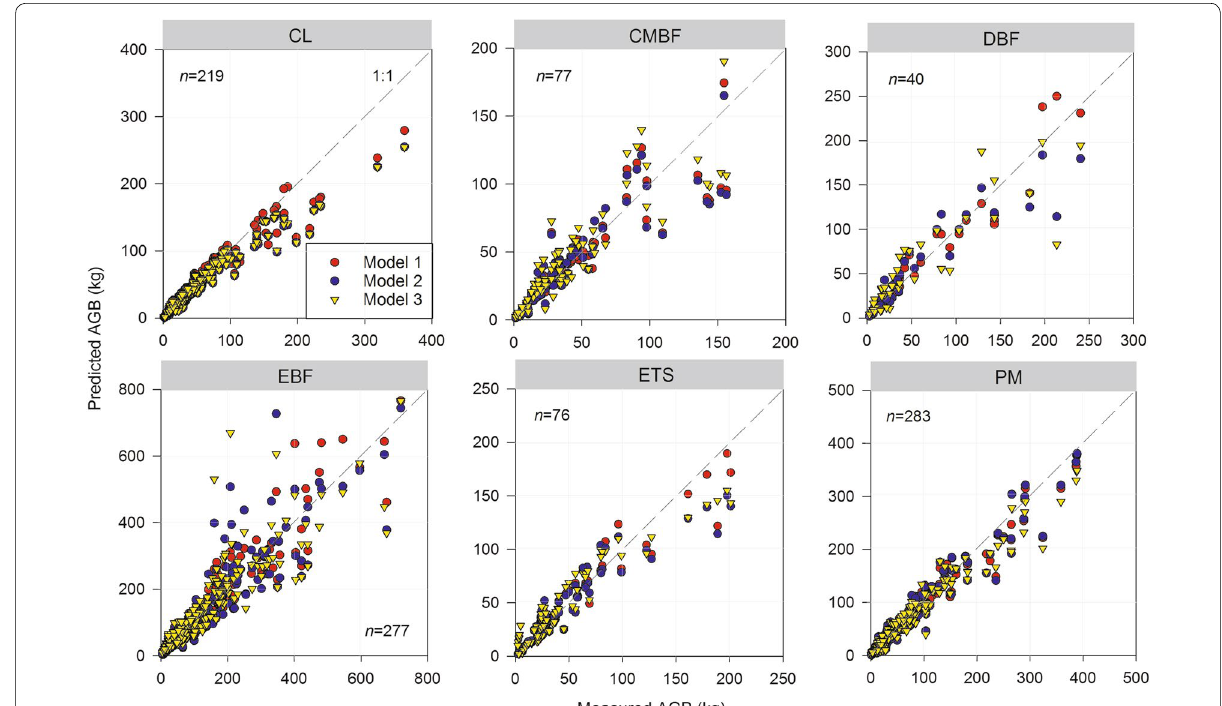
Fig. 2 Comparison measured AGB (aboveground tree biomass) and predicted AGB for six subtropical forests from three allometric models at dif- ferent scales (model 1, model 2 and model 3) in China. Model 1: allometric model at ecoregion scale, model 2: dummy variable allometric model at both ecoregion scale and regional scale, and model 3: allometric model at regional scale. See Table 1 for the abbreviations of the six forest